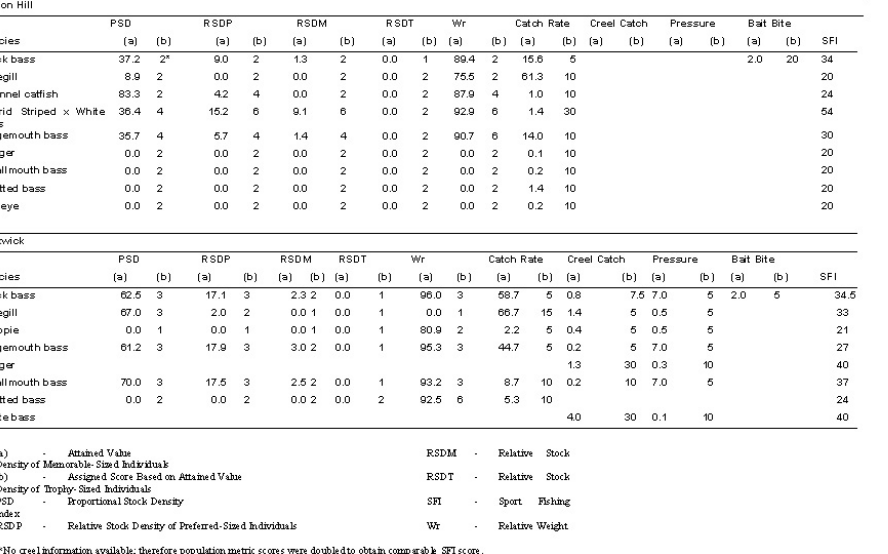
Sport Fishing Index Results for Melton Hill and Pickwick